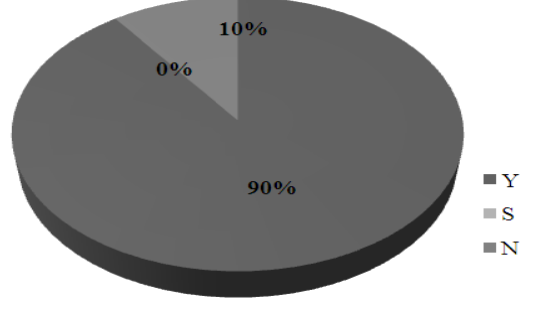
Fig. 14. Stakeholder